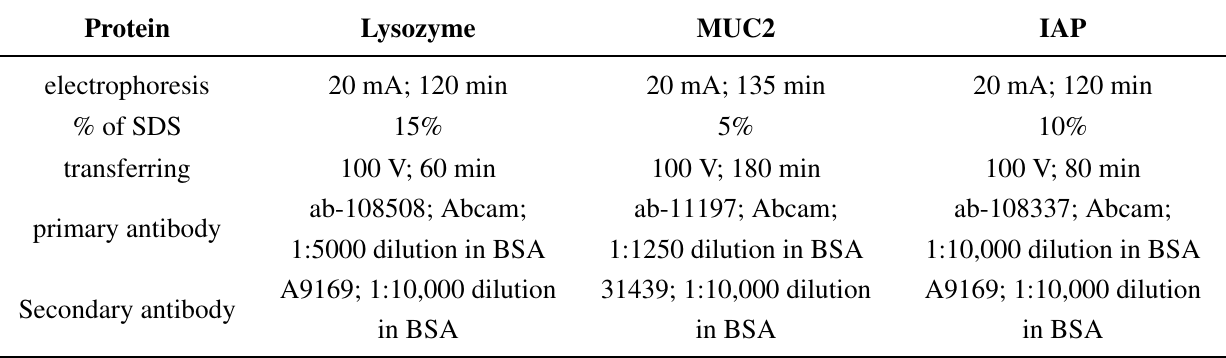
Table 1. Key points of Western blot analysis for lysozyme, MUC2 and IAP in ileal tissue